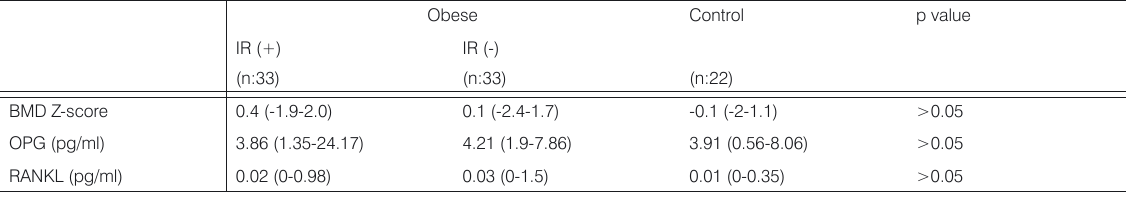
* Data are presented with the mean ± SD or median (min-max)